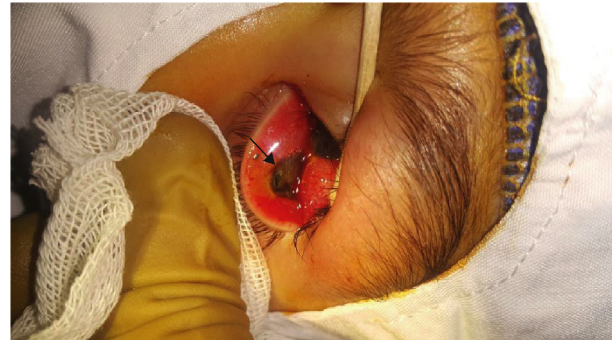
Figure 3: Necrosis in the inferior fornix of the left eye due to button battery exposure (black